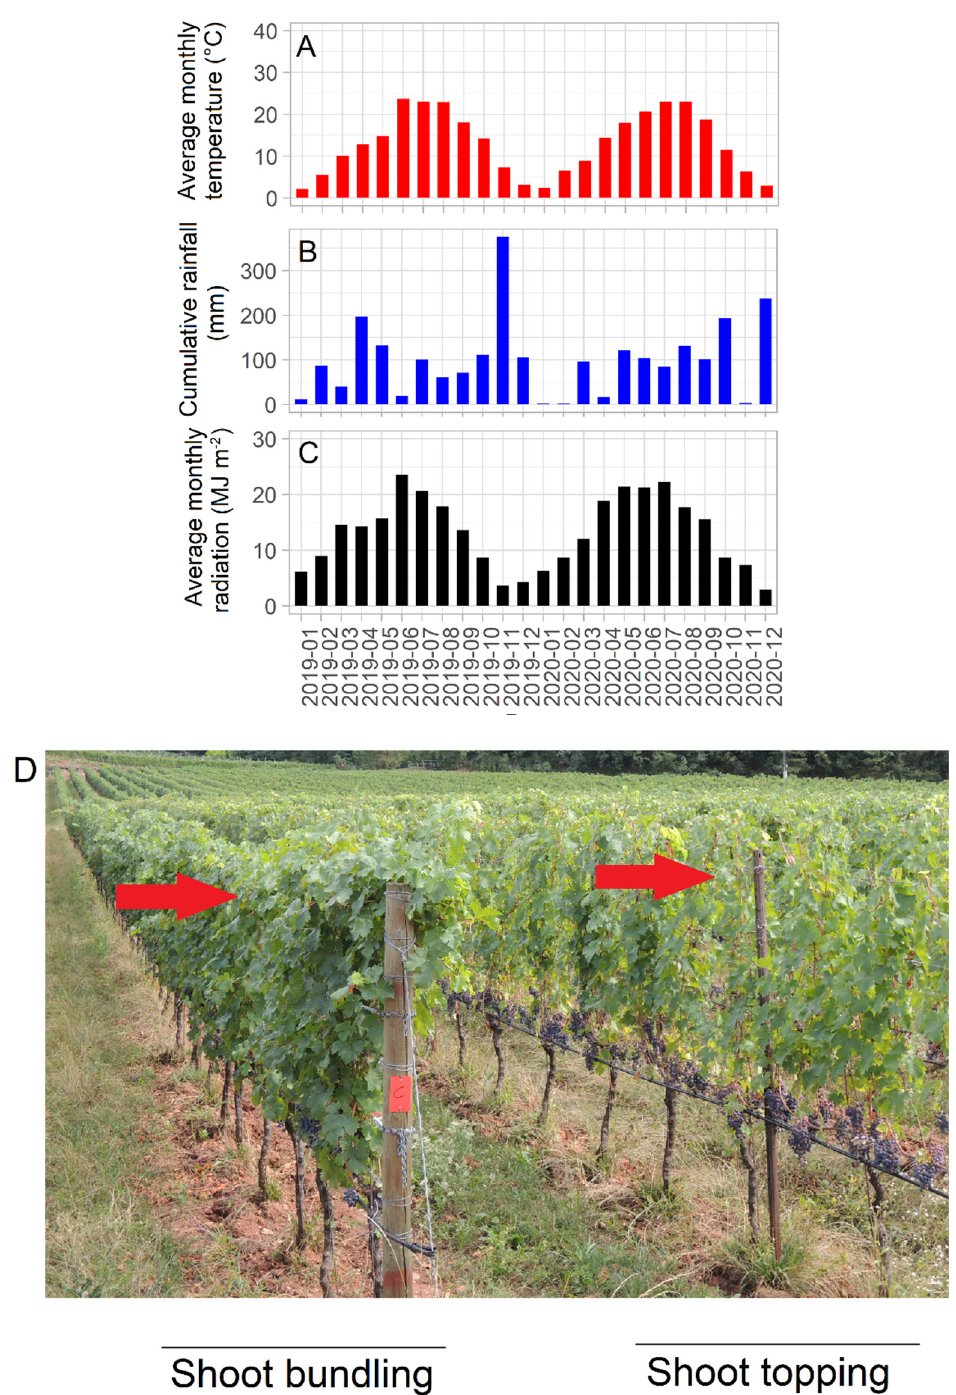
Figure 1. Dynamic of environmental conditions during 2019 and 2020. Average monthly temperature ( A ), cumulative monthly precipitation ( B ), and average monthly radiation ( C ). ( D ) An example of the application of shoot bundling or topping.